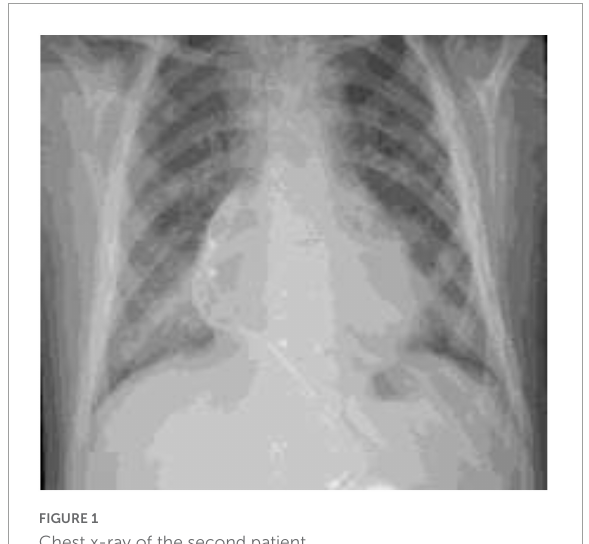
FIGURE1 Chest x-ray of the second